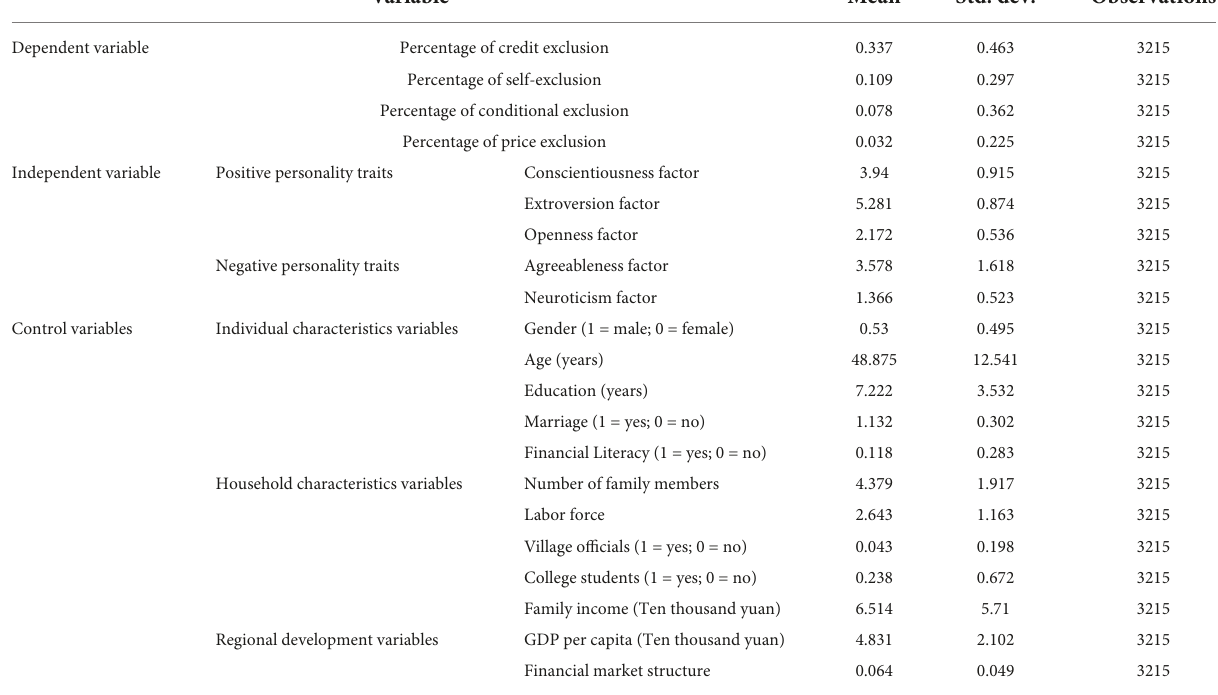
TABLE 5 Descriptive